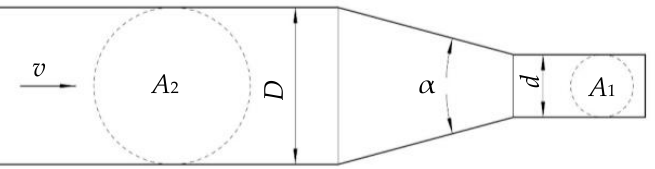
Figure 4. Reducer with progressively smaller through the diameter. Note: α is nozzle shrinkage angle, ( ◦ ); D and d are the inlet and outlet of the nozzle, respectively, mm; v is nozzle section average flow rate, m · s − 1 . calculated as shown in Table